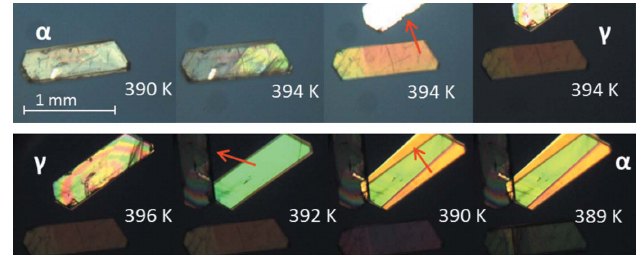
Figure 12 Thermal stage polarisation microscopy snapshots showing an example of jumping crystals; (top) (cid:2) ! (cid:6) phase transition of dl -Nle during heating and (bottom) (cid:6) ! (cid:2) phase transition of dl -Nle during cooling. The jumping crystal parts are indicated by the arrows.